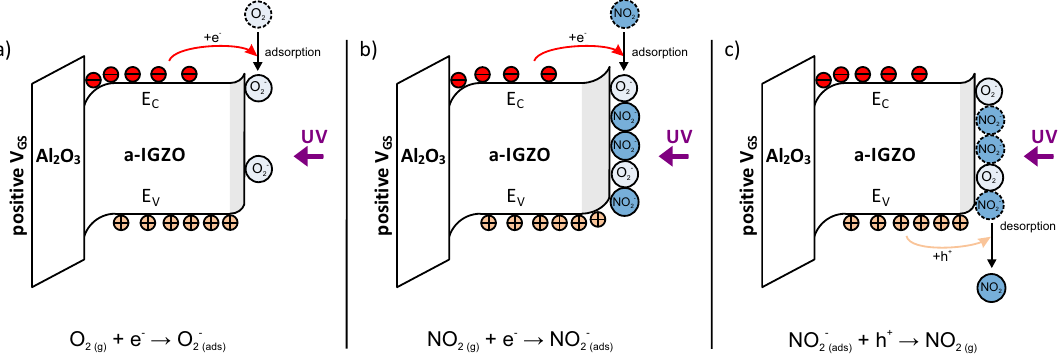
Figure 3. Schematic band diagram of the TFT sensing layer and gate insulator under UV-illumination and in contact with gas. Under illumination with UV-light, the generated electron-holes pairs are separated to the conduction and valence band, respectively. This results in an increased number of charge carriers thereby an increased transistor drain current (I D ). ( a ) oxygen molecules from the atmosphere adsorb at the semiconductor surface acting as surface-acceptors and therefore forming a back-channel depletion as indicated in the band diagram. Due to this depletion region, the transistor I D decreases. ( b ) As soon as the NO 2 comes in contact with the sensor, it also adsorbs at the surface acting as an electron-acceptor. The back channel depletion area will increase and the transistor I D decreases further. ( c ) After returning to normal atmosphere without NO 2 , the adsorbed NO 2 − molecules desorb from the surface by the help of a positive charge from the semiconductor valence band. The back-channel depletion width and the I D return to the states described in ( a